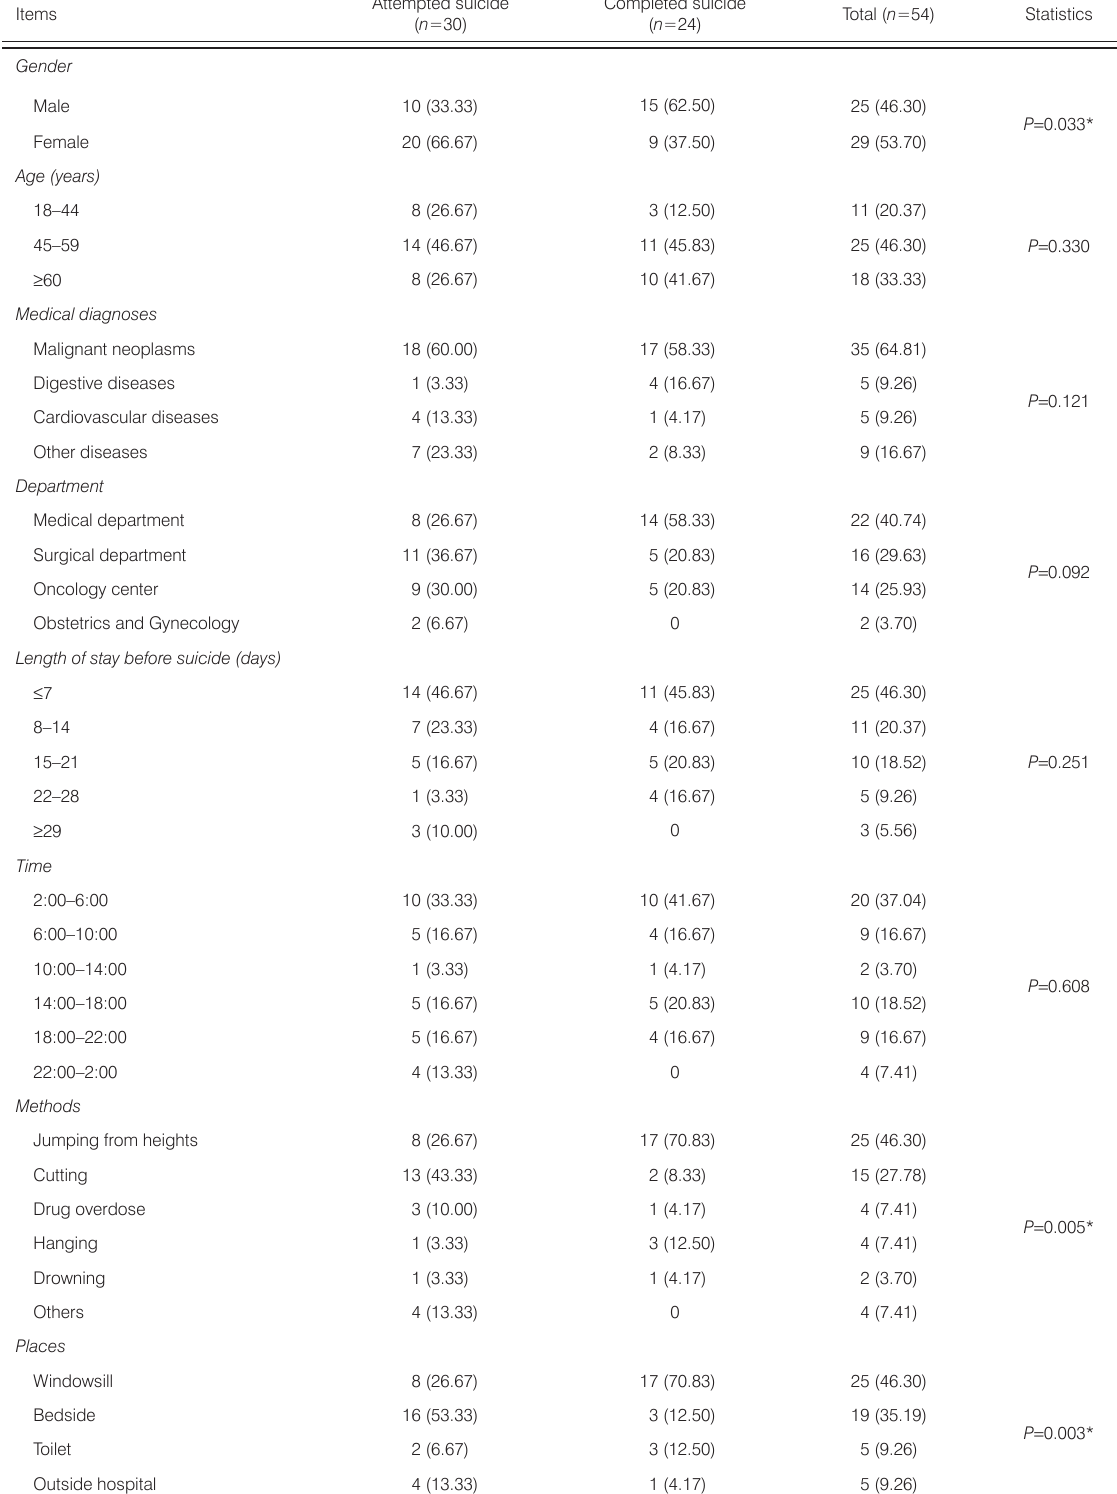
Table 1. Characteristics of suicidal inpatients, n (%). Note: * P <0.05 indicates a statistically significant comparison between attempted and completed suicidal